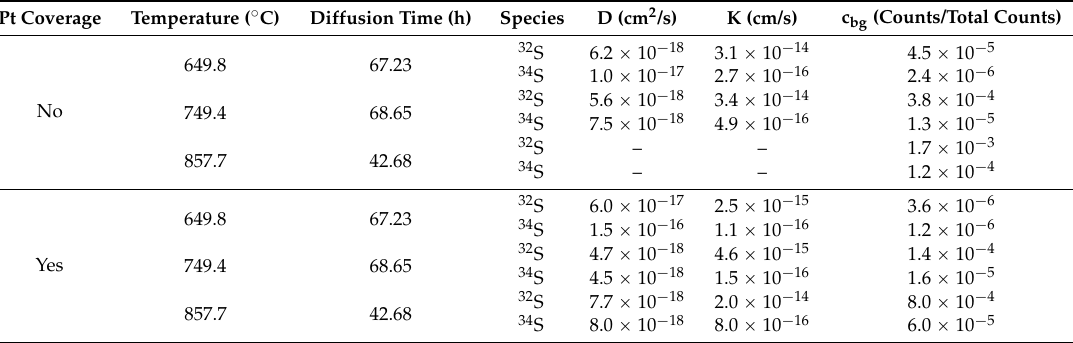
Figure 4. ToF-SIMS depth profiles of the normalized sulphur signal of GDC 10 polycrystals heat treated at the specified temperature in an atmosphere of dry 2.5% vol H 2 in Ar for 72 h. As a reference sample an untreated GDC 10 polycrystal was used. The box highlights a surface enrichment region, which was fitted to Equation (1); the results are given in Table 2. Table 2. Apparent diffusion coefficients D and surface incorporation constants k for sulphur incorporated into GDC 10 polycrystals in a dry ~2.5% vol H 2 atmosphere in Ar with 10 ppm H 2 S for specified times and temperatures. D and k , as well as the background concentration c bg were evaluated using Equation (1) where applicable. For the uncovered sample at 857.7 ˝ C, the background concentration was estimated